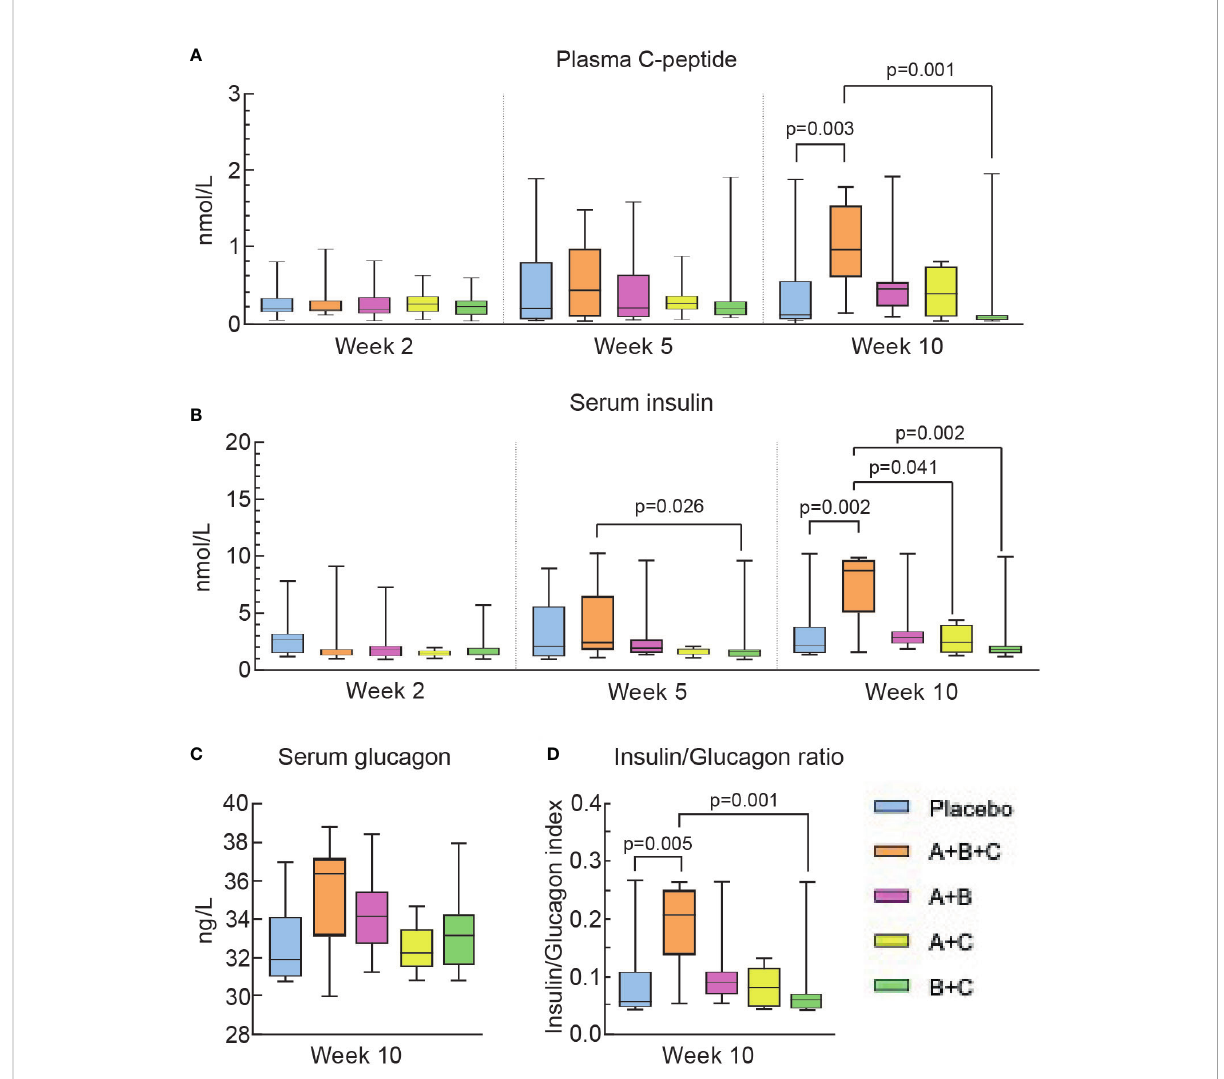
FIGURE 4 Triple therapy (A+B+C) increases C-peptide and insulin levels in diabetic NOD mice. Differences in the levels of plasma C-peptide (A) , serum insulin (B) , serum glucagon (C) , and the insulin/glucagon ratio (D) were analyzed using the Kruskal-Wallis test with Dunn ’ s post hoc . The box- whisker plots represent median values with interquartile width and